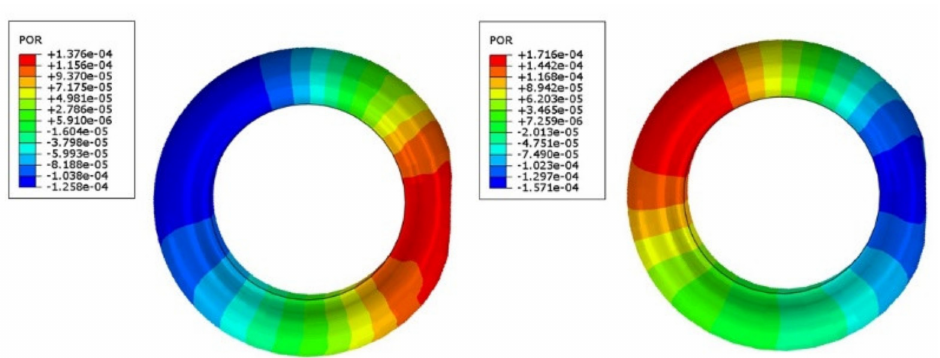
Figure 21. The acoustic pressure amplitude distribution for the running speeds of 80 km/h and 100